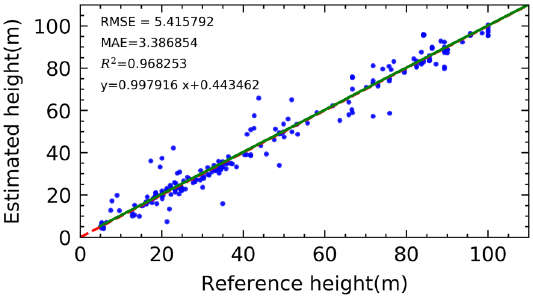
Figure 13. Accuracy of building height predictions.